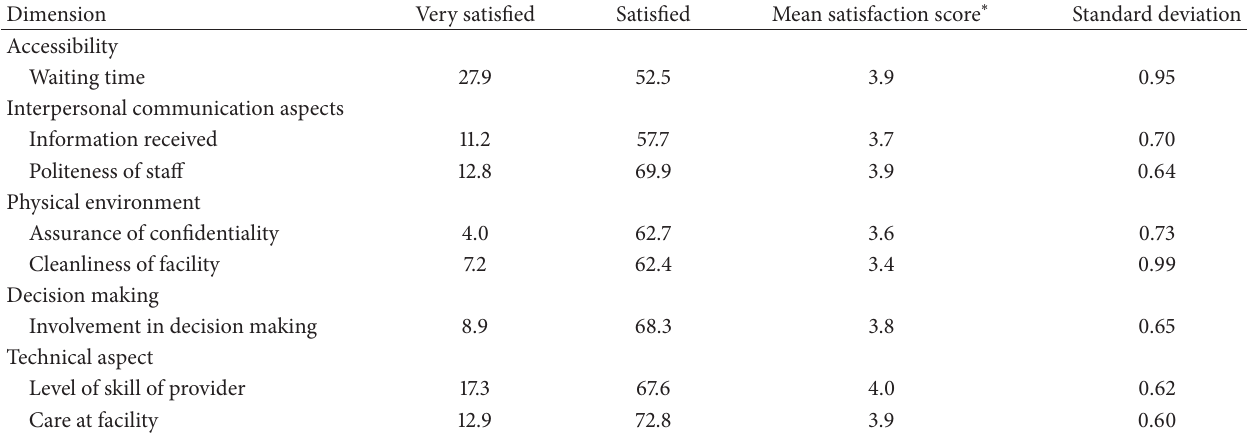
Table 2: Percentage of the mothers by level of satisfaction with perinatal care ( 𝑁 = 447